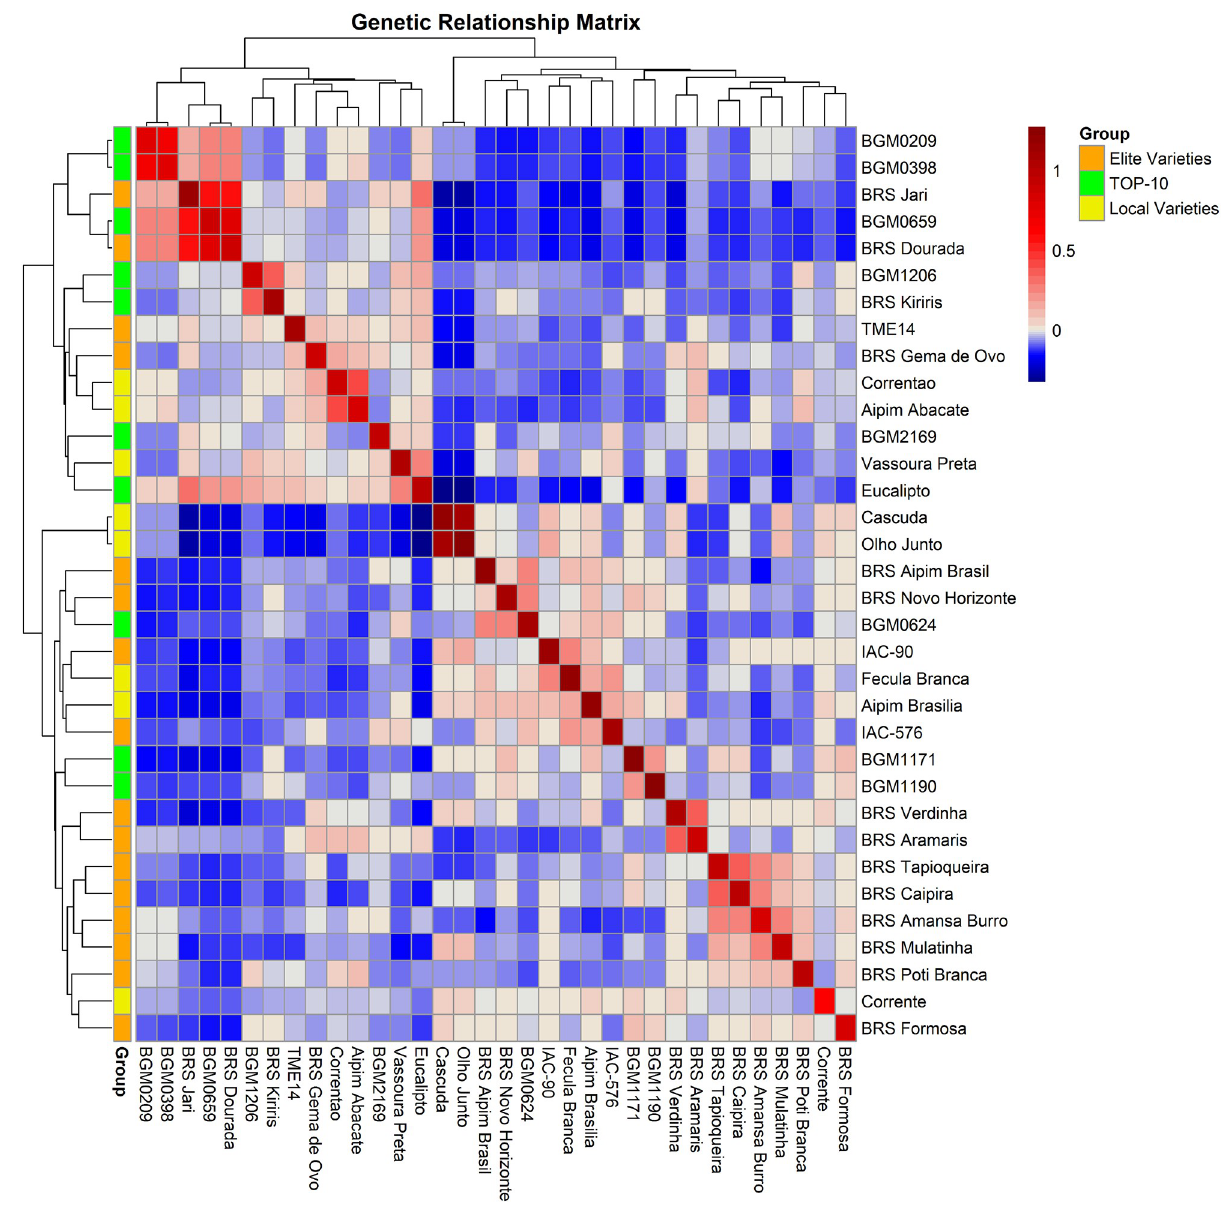
Fig 5. Heatmap of the genomic kinship of 10 putative resistance sources to cassava root rot disease, 16 elite varieties, and 7 cassava landraces based on analysis of 72,023 single nucleotide polymorphisms markers.